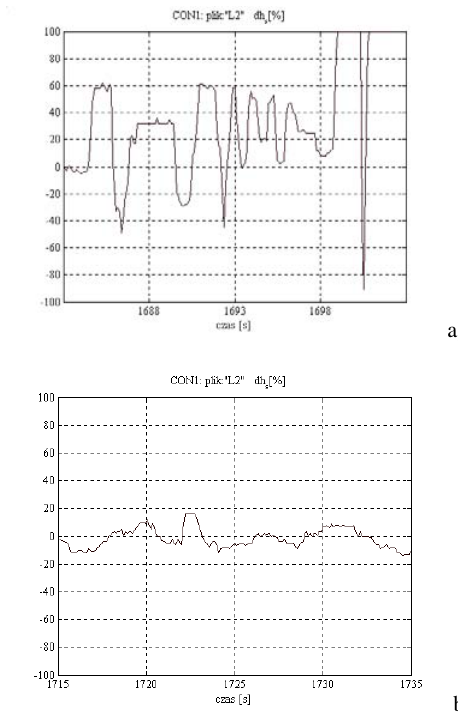
Fig 6. The forming function using fuzzy logic (b), decreased the number and amplitude of the displacements of the side stick compared to control laws that were not augmented (a)